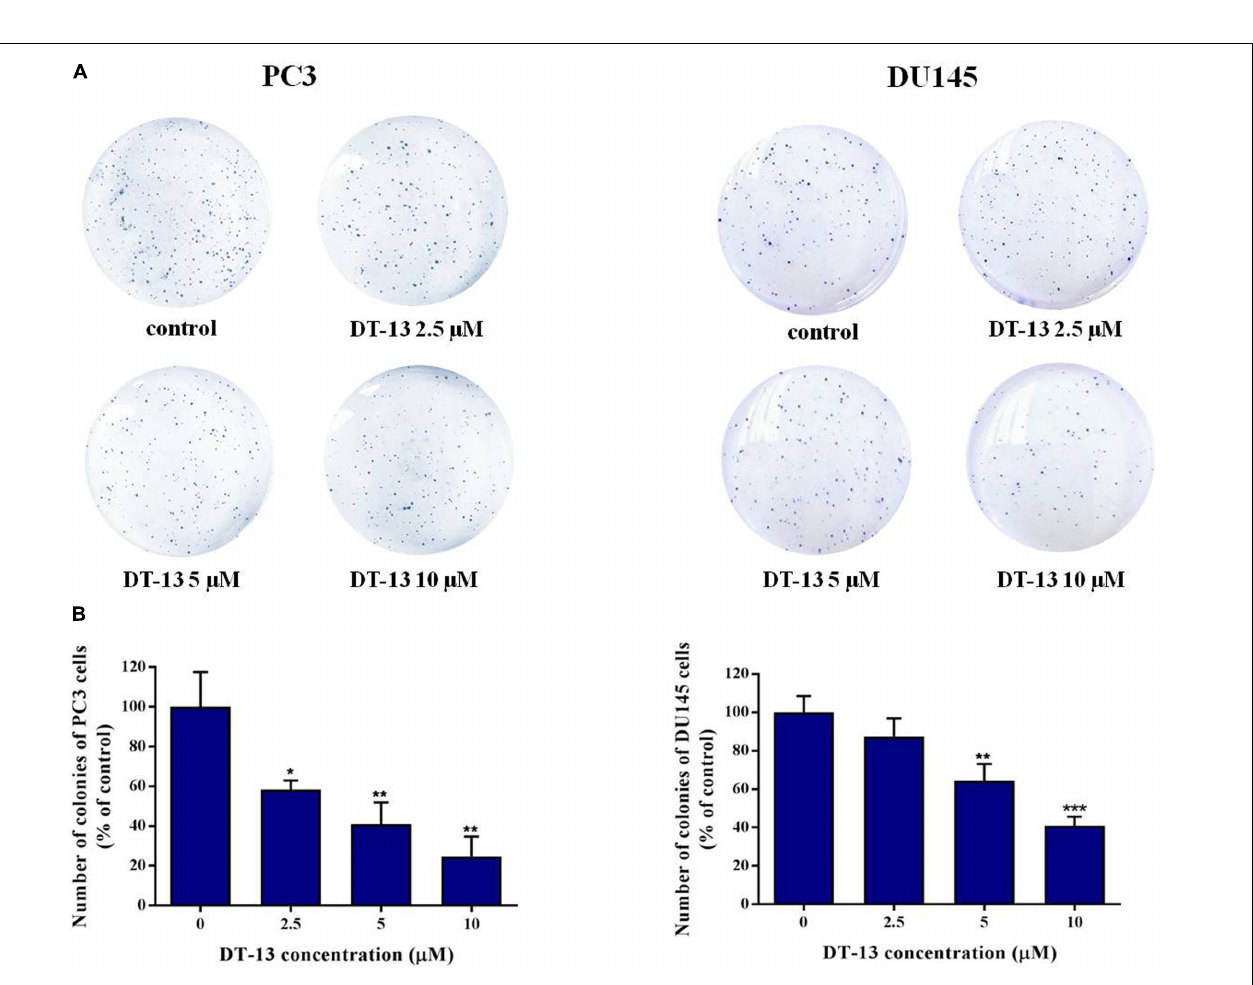
Frontiers in Pharmacology | www.frontiersin.org